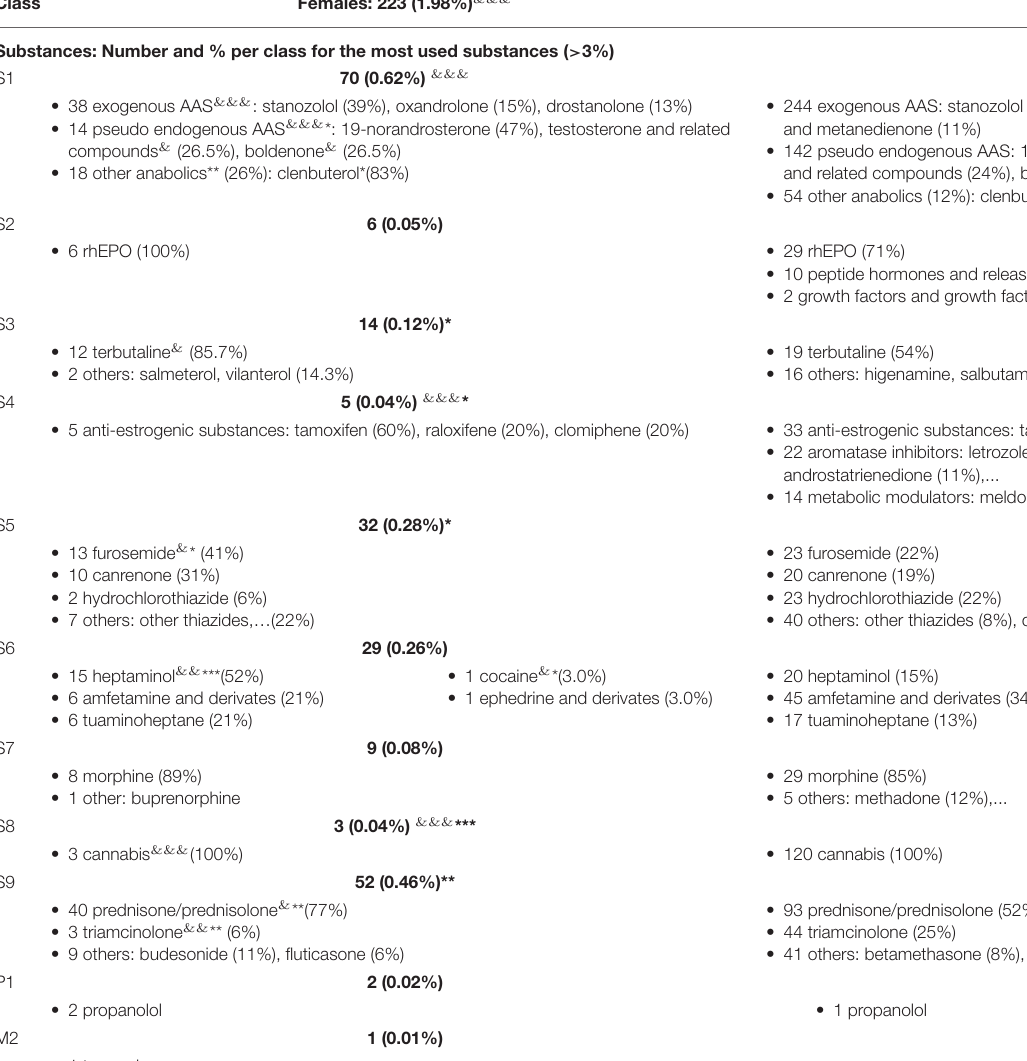
TABLE 2 | Number and % per class for the most used substances ( >